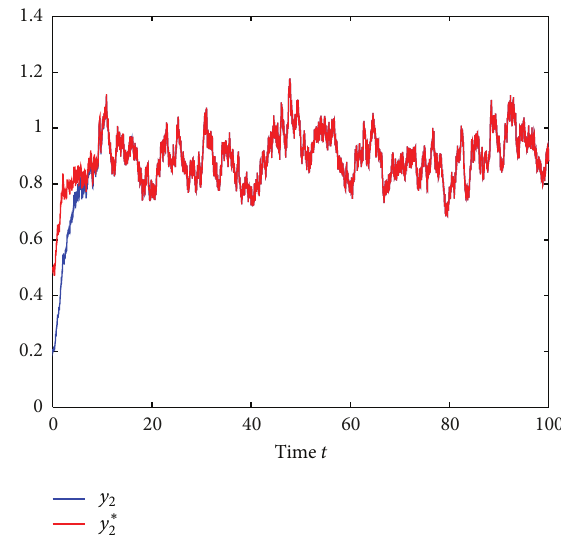
Figure 2: The sample path of (𝑦 2 (𝑡);𝑦 ∗ 2 (𝑡)) in the same coordinate